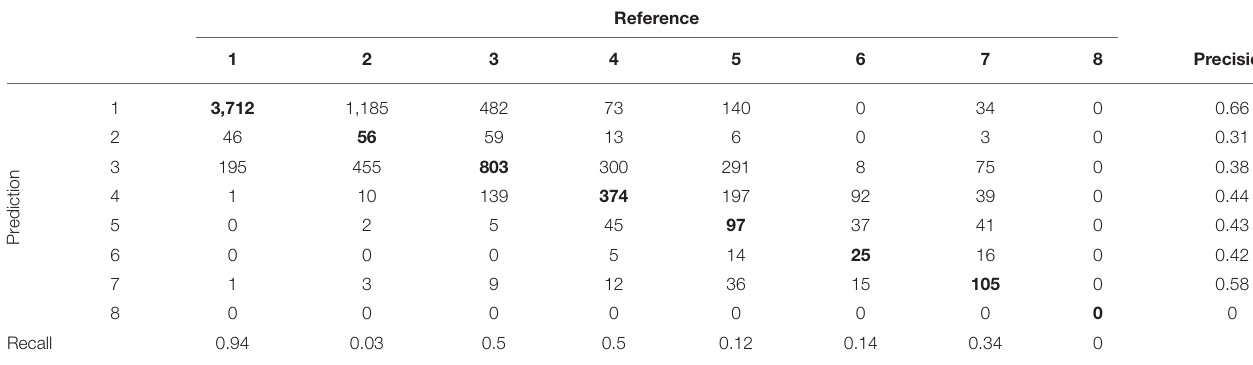
TABLE 5 | Confusion matrix results of right ear machine learning predictions.